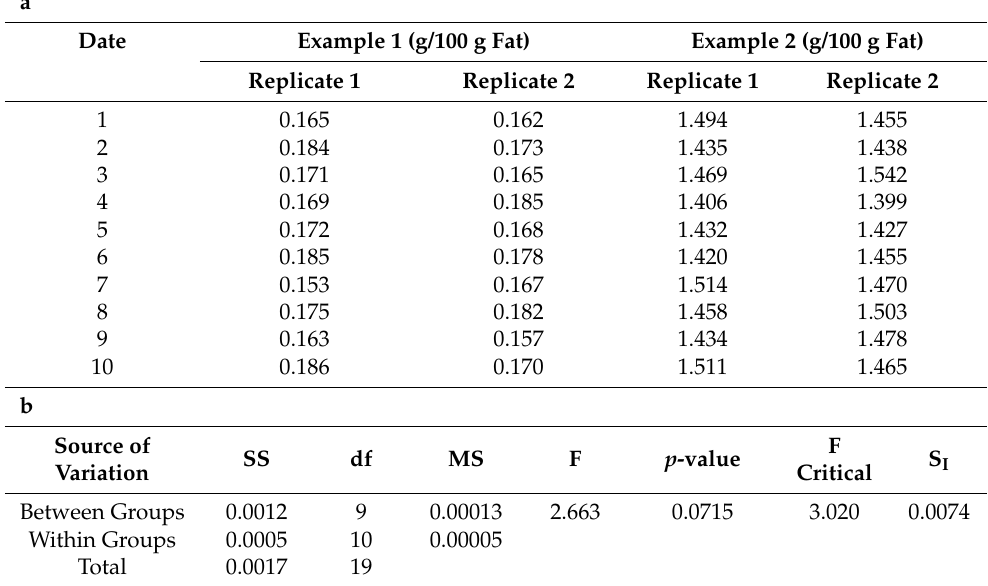
Table 3. (a). Results of butyric acid in milk products, analysis on different days, twice a day for 10 days. (b). Results of intermediate precision (SI) of butyric acid in sample 1 assessed by